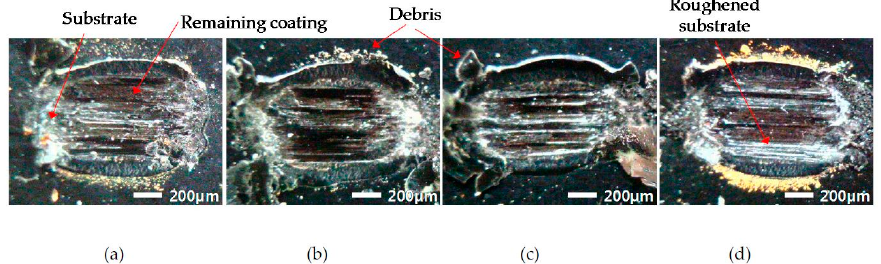
Figure 8. Captured surface images at the friction coefficient of 0.5: ( a ) 1 s; ( b ) 10 3 s; ( c ) 10 5 s and ( d ) 5 × 10 5 s.